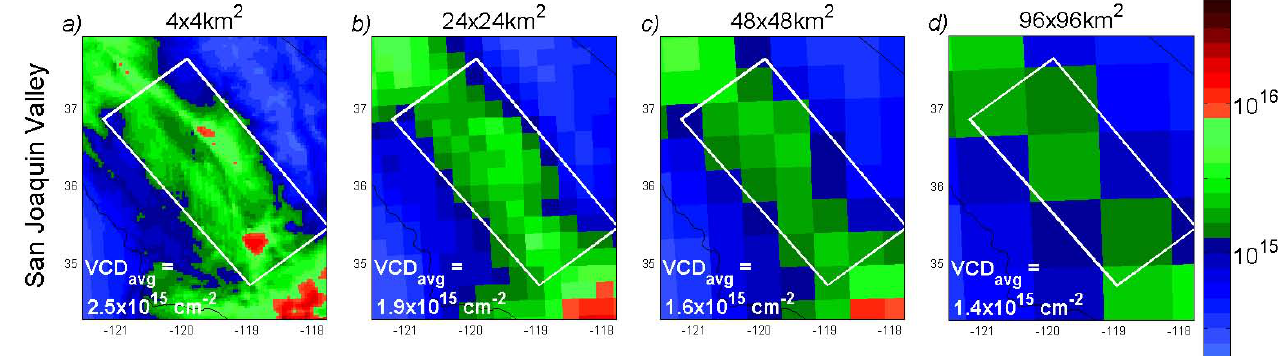
Fig. 9. WRF-CHEM 3–7 July 2006, 1p.m.LST average NO 2 column (moleculescm − 2 ) over the San Joaquin Valley at (a) 4km, (b) 12km, (c) 24km, and (d) 48km model resolution. NO 2 column is averaged over a sub-domain (white box) and reported at the bottom of each